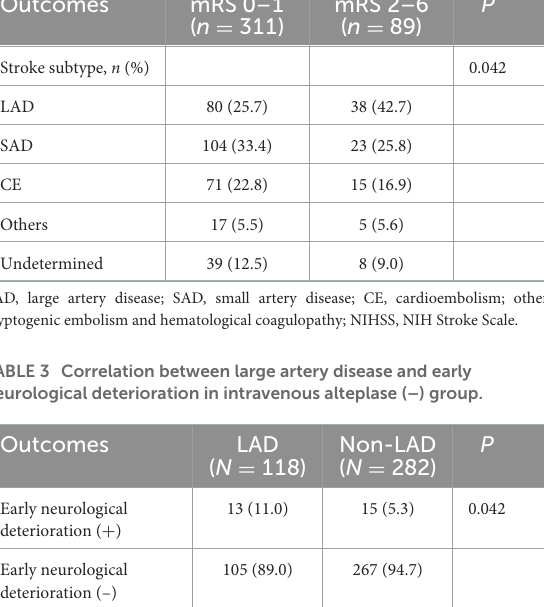
TABLE 2 Analysis of functional outcome according to TOAST classification in intravenous alteplase (–) group. Outcomes